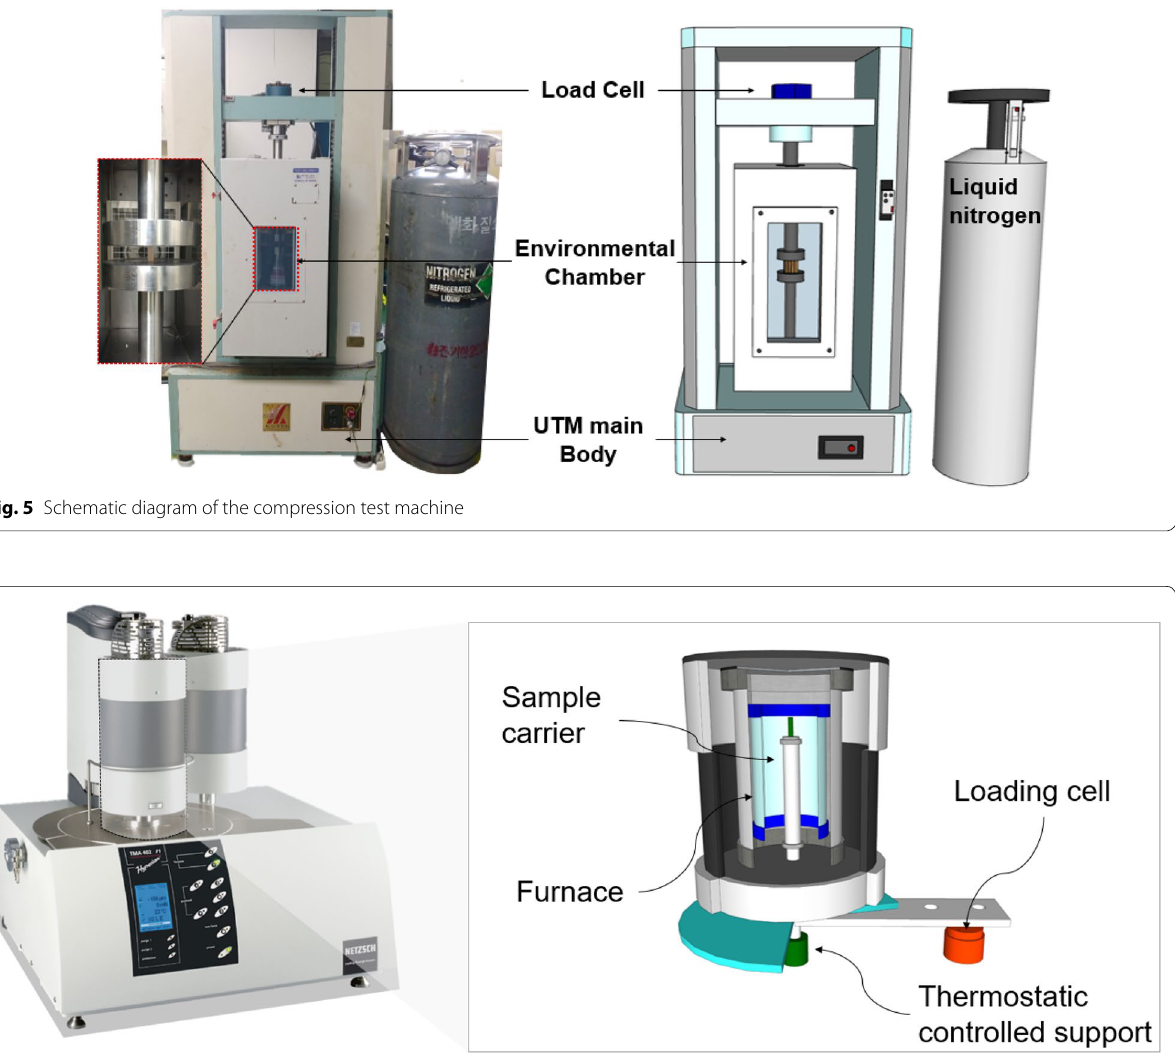
Fig. 6 Schematic diagram of